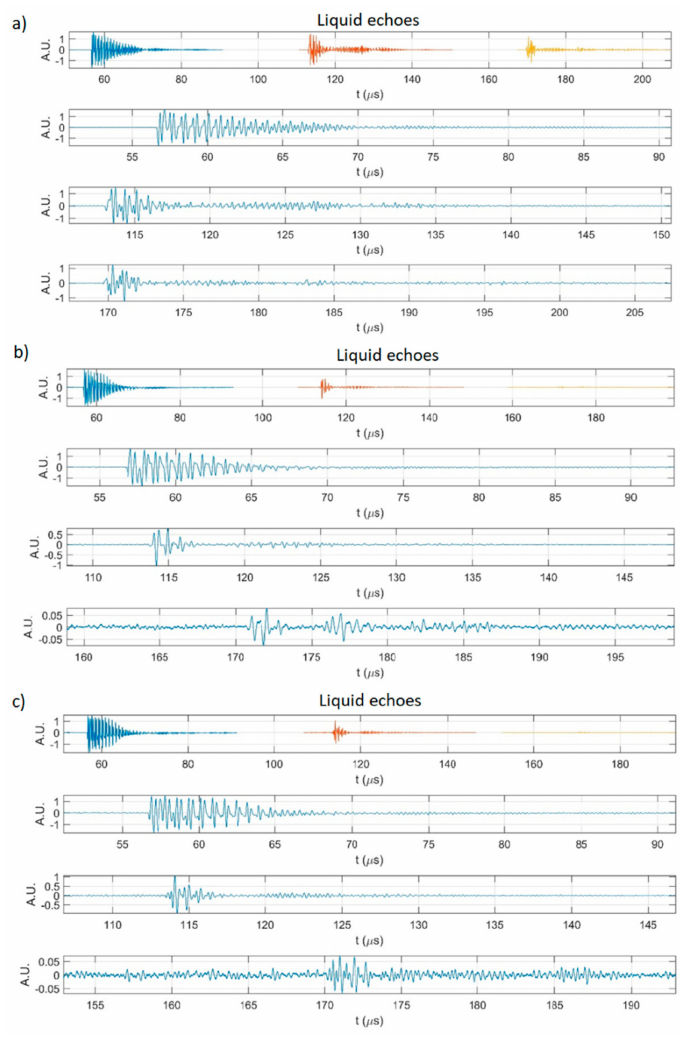
Figure 4. The first three echoes for the reference liquid ( a ) HApAg5 ( b ), HApAg20 ( c ), at 5 MHz grouped (top) and separated in the following three windows of the